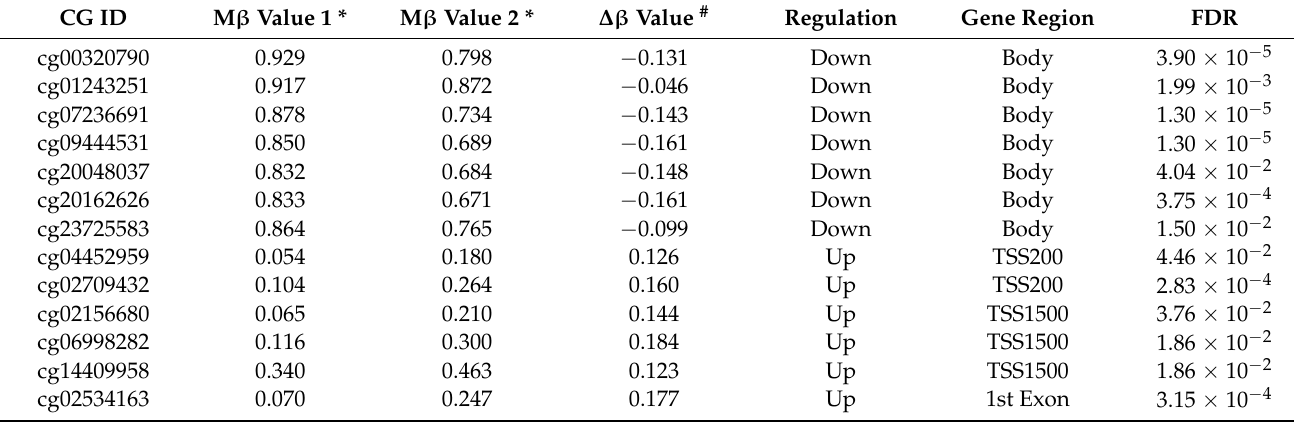
Table 8. Differential methylation and expression analysis of ENPP2 between normal liver and HCC tumors from TCGA cases. CG ID M β Value 1